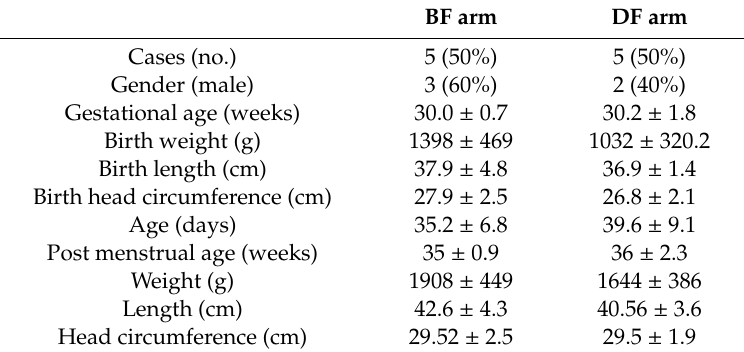
Table 2. Anthropometric characteristics per arm at enrollment, expressed in mean ±